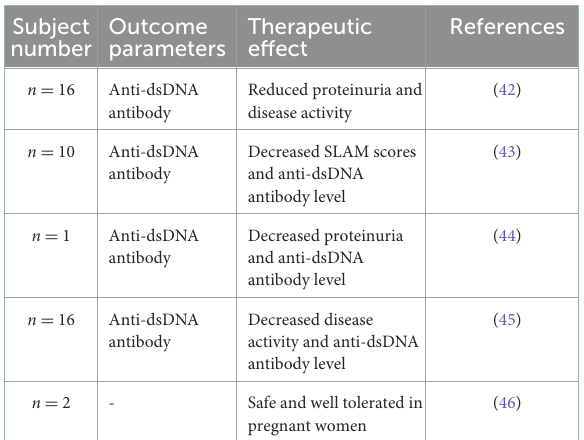
TABLE 2 Summary of the case reports involving the application of Ig-Therasorb in treating